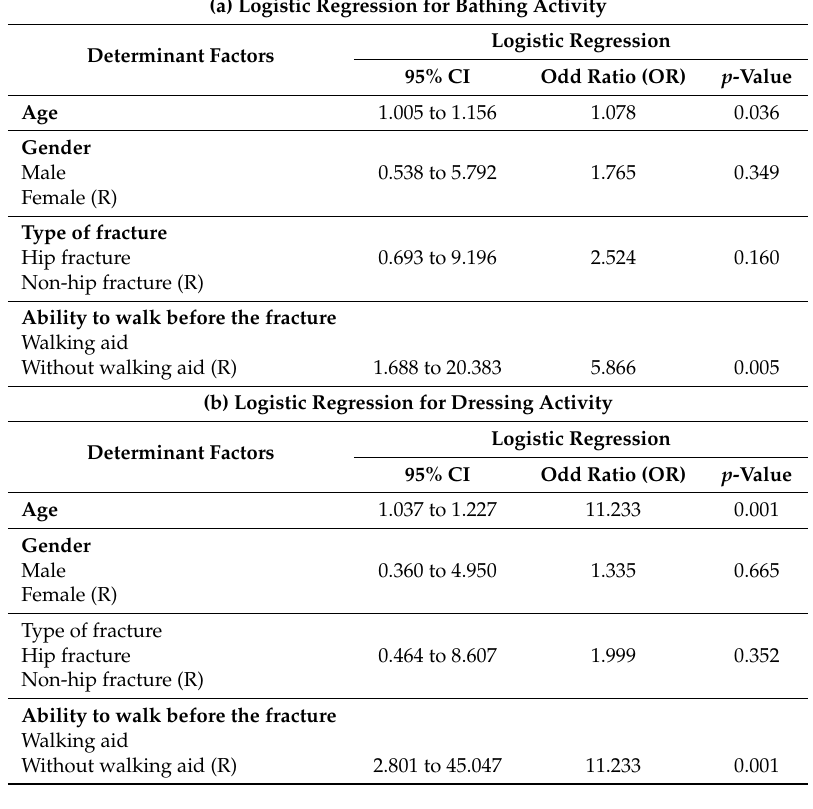
Table 4. Logistic regression models for all ADL in all three phases. ( a ) Logistic regression for determinant factors for bathing activity, ( b ) dressing activity, ( c ) transferring activity ( d ) toileting activity, ( e ) continence activity ( f ) feeding